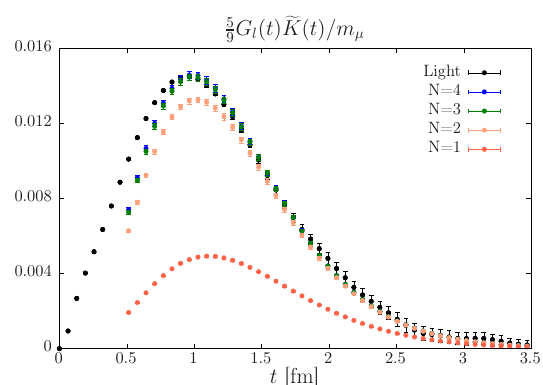
Figure 1. The light quark contribution to the integrand of Eq.(4) in units of m µ (black circles), compared to the corresponding re- construction from the isovector contribution. Coloured symbols show the accumulation of up to four lowest-lying states in the isovector channel. Data have been computed for m π =